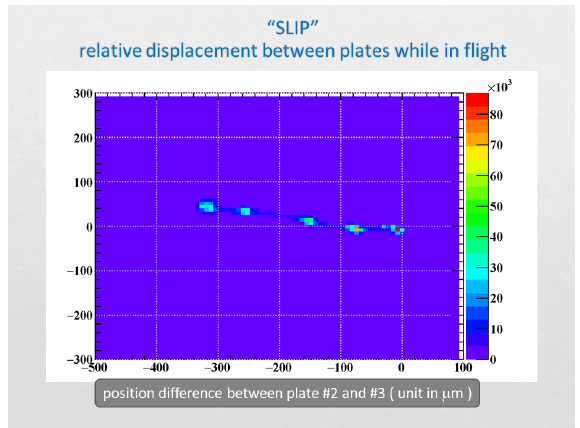
Fig 7. A method to search for vertices using linklets. Vertices in a region just upstream of plate #5, where a stainless plate is placed, are searched.